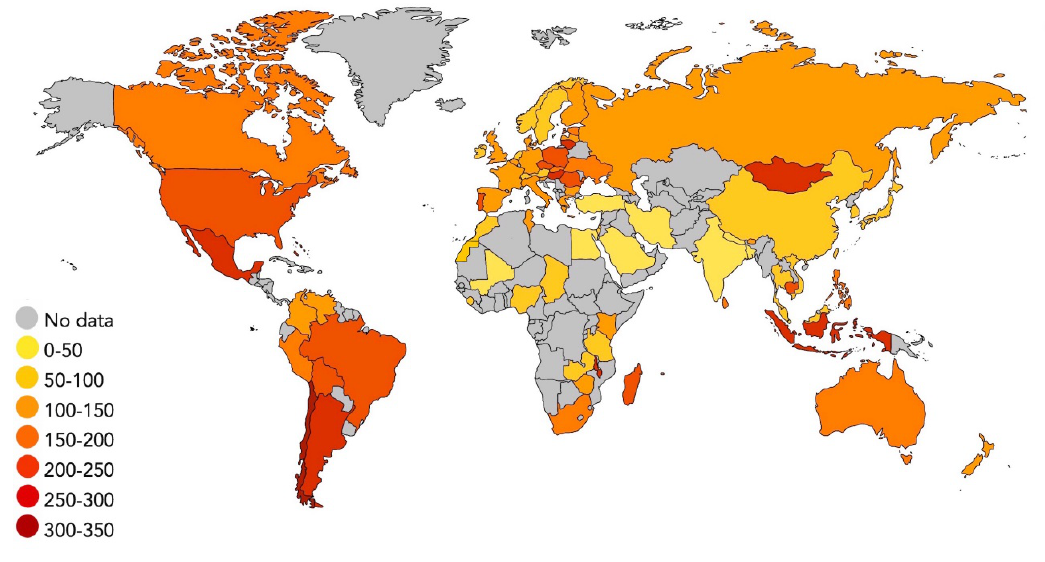
Figure 1. A map of countries across the globe depicting the frequency of dogs per 1,000 people. Darker shades represent countries with greater numbers of dogs per capita. Grey shading indicates countries for which data was not available.